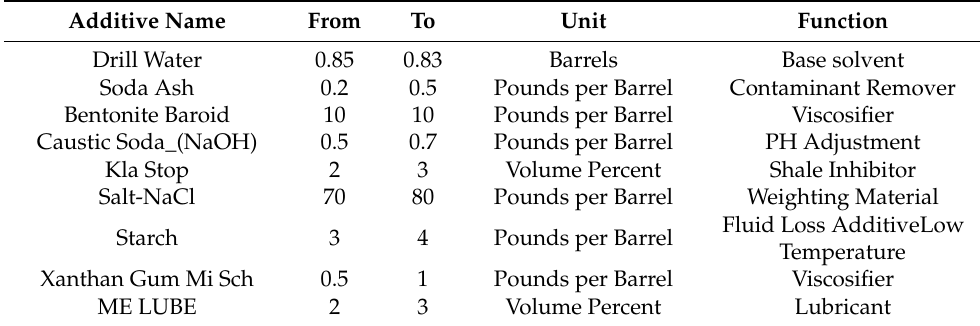
Table 5. The composition of the water-based drilling fluid, as received from the oil company labs.